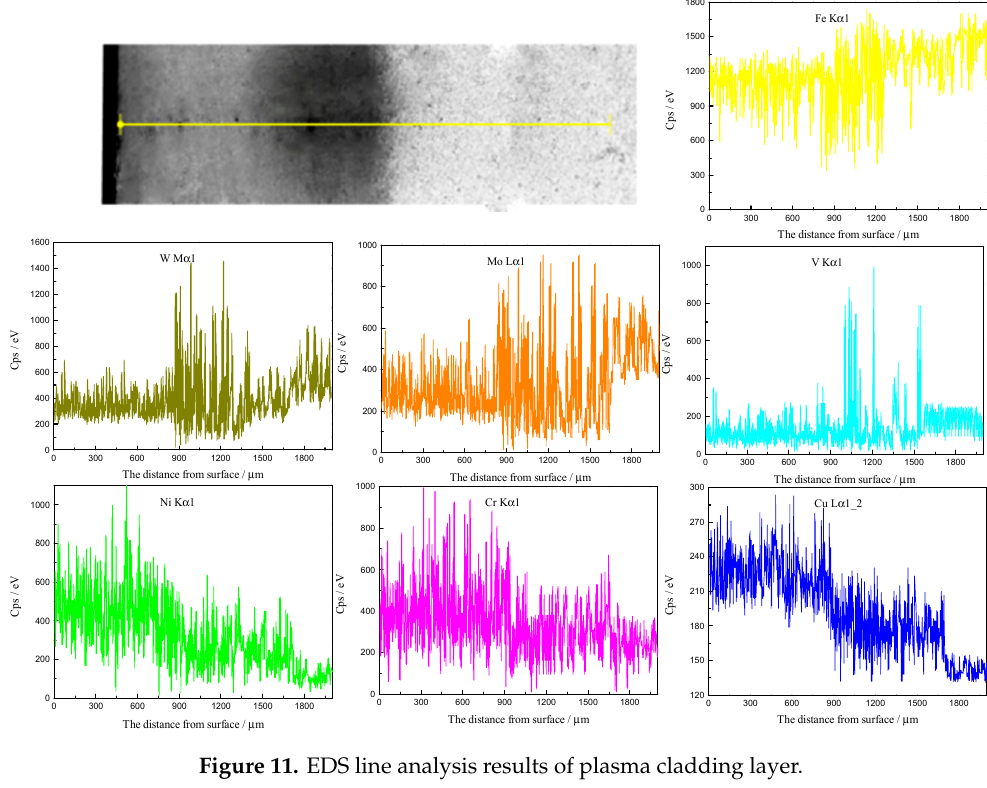
Coatings 2020 , 10 , 641 Figure 11. EDS line analysis results of plasma cladding layer. Figure 11. EDS line analysis results of plasma cladding layer.